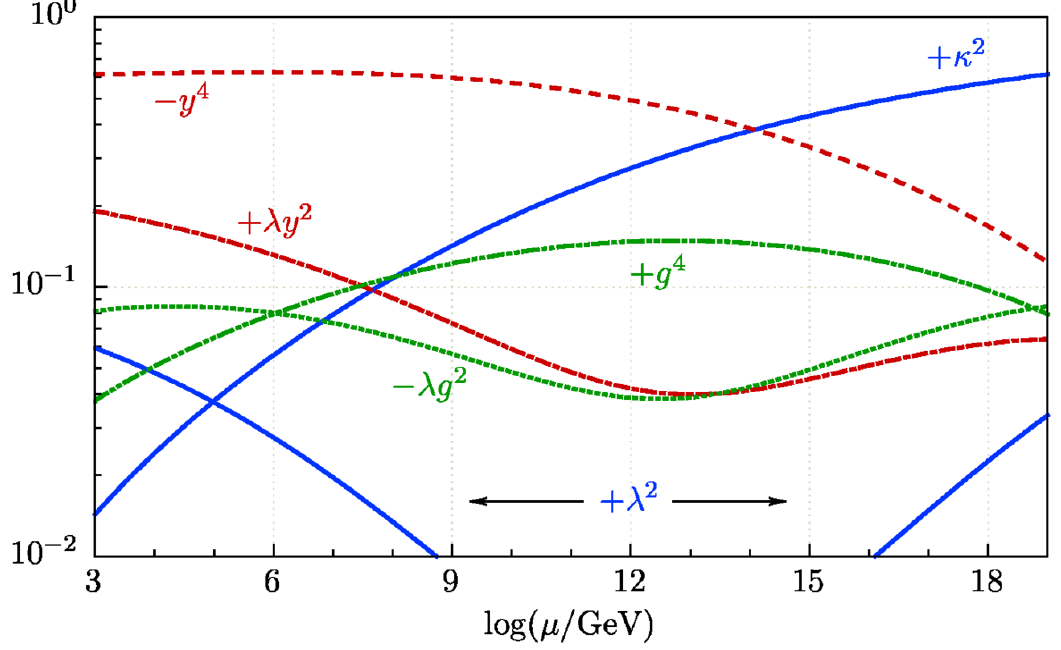
Figure 8 . Running of the relative contributions to the beta function of the Higgs self-coupling for the example point in eq. (2.30). The di(cid:11)erent contributions from the scalar, Yukawa and gauge sectors are displayed in blue, red and green, respectively (cf. also caption of (cid:12)gure